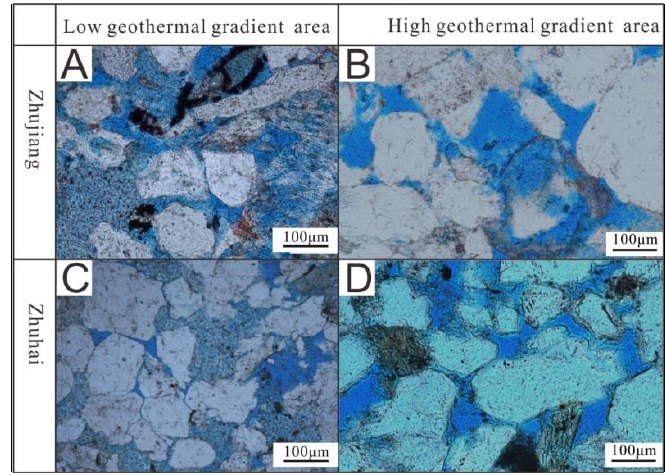
Figure 4. Typical thin-section photomicrographs of pore types in the Baiyun Sag. ( A ) Gra = 3.86 °C/100 m, the pore system consists of intergranular pores and feldspar dissolution pores. Kaolinite fills the intergranular pores. ( B ) Gra = 4.54 °C/100 m, intergranular pores are the main type of pore. ( C ) Gra = 2.87 °C/100 m, dot-line contact, intergranular pores are the main type, but secondary pores are present. ( D ) Gra = 4.97 °C/100 m, intergranular pores are the main type of pore.